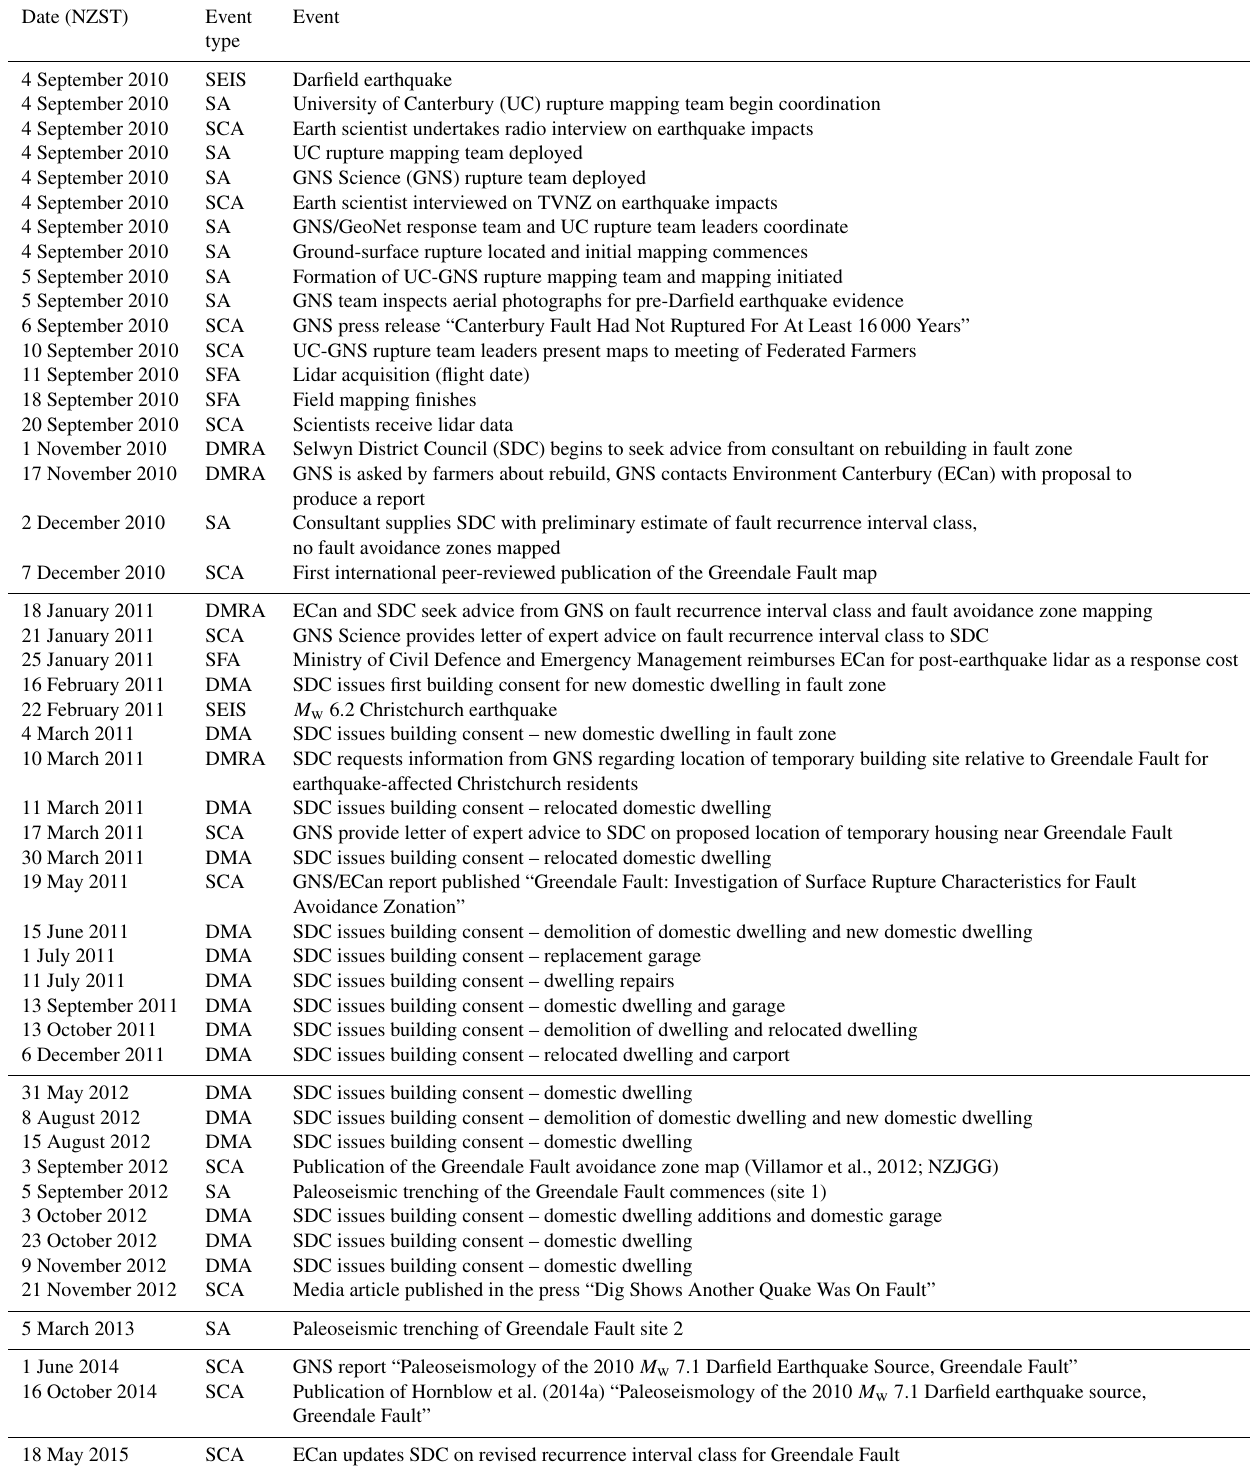
Table 2. Fault rupture response timeline: list of scientist and decision-maker actions. Date